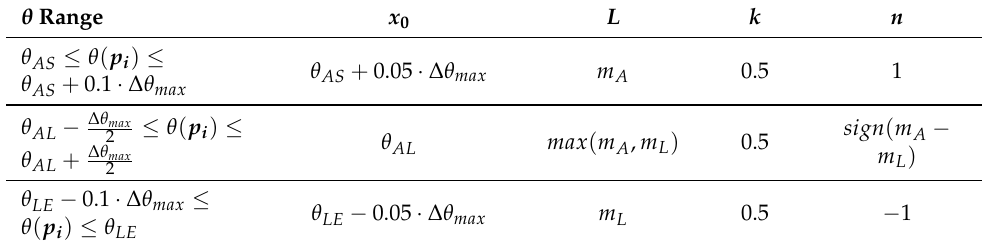
Table A1. Logistic function